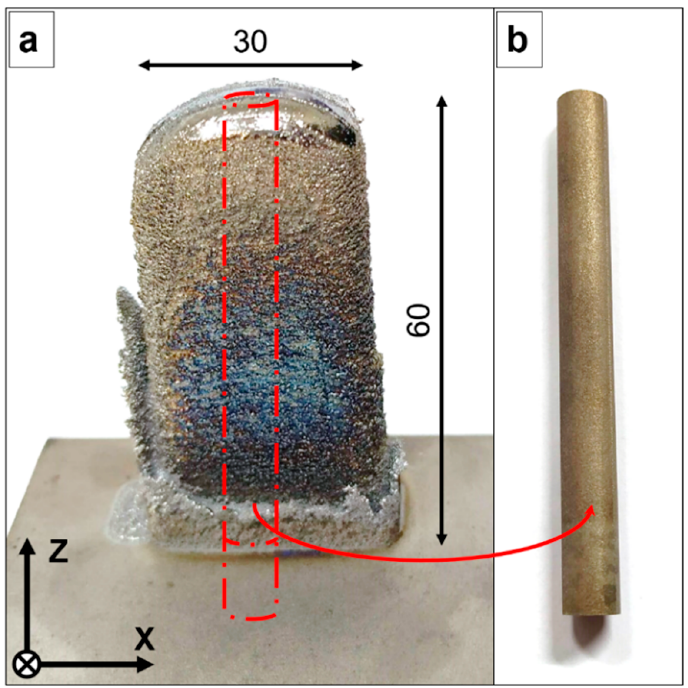
Figure 3. ( a ) Laser-deposited Ti-42Nb vertical specimen. ( b ) Vertical cylindrical sample. All dimen- sions are shown in mm.